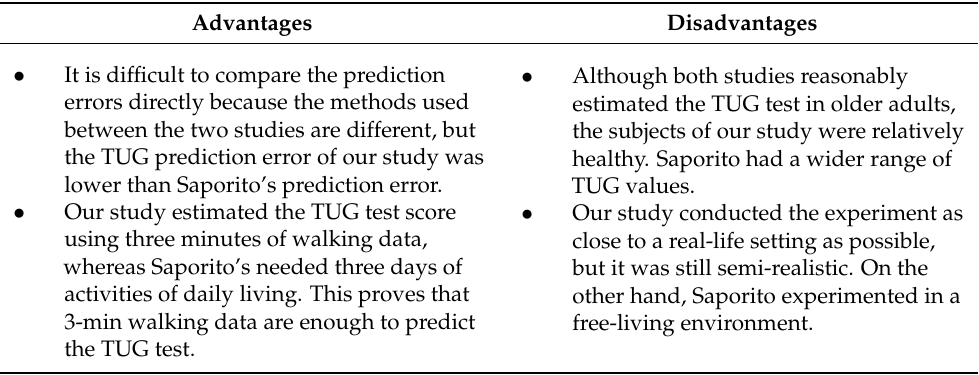
Table 9. Comparison of the advantages and disadvantages of our study with those of